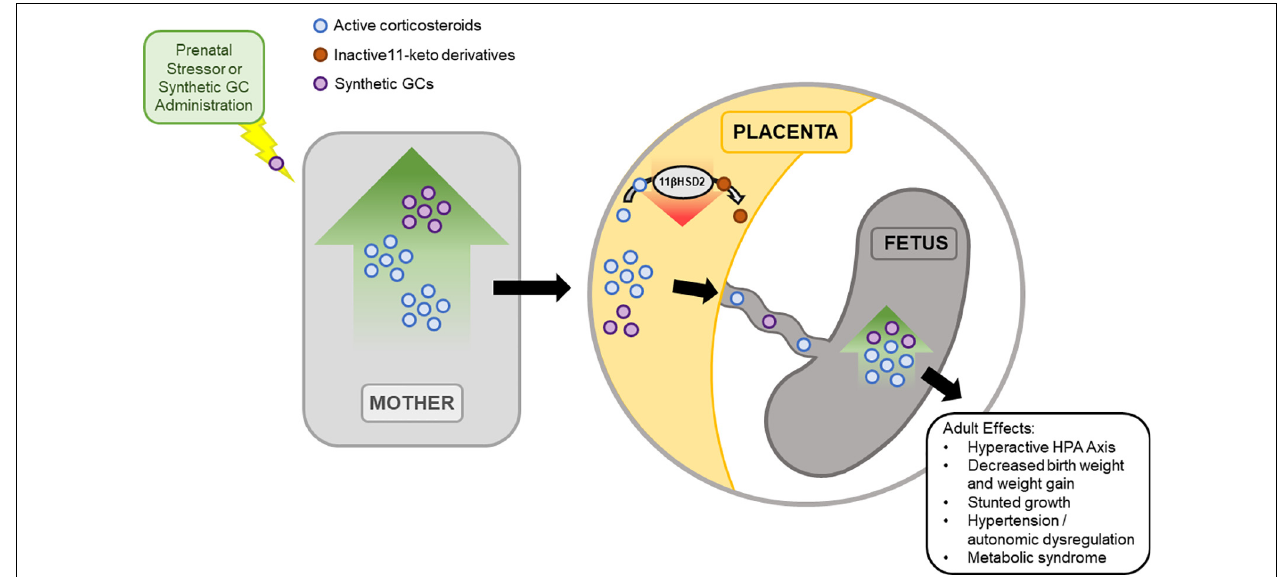
FIGURE 3 | Prenatal exposure to excess GCs has short- and long- term effects. During pregnancy, 11- β hydroxysteroid dehydrogenase type 2 (11 β -HSD2) expression in the placenta mediates the fetus’ exposure to excess maternal GC. 11 β -HSD2 regulates the level of active GCs through the oxidation of maternal corticosteroids into inactive 11-keto derivatives, reducing fetal exposure to active GCs. While 11 β -HSD2 concentration in the placenta is high during most of gestation, 11 β -HSD2 levels drop during late gestation. As a result, fetal exposure to maternal GCs increases, leading to short term effects, observed immediately at birth into adulthood. To note, synthetic GC does not act as a substrate for 11 β -HSD2 and bypasses this system to the fetus.